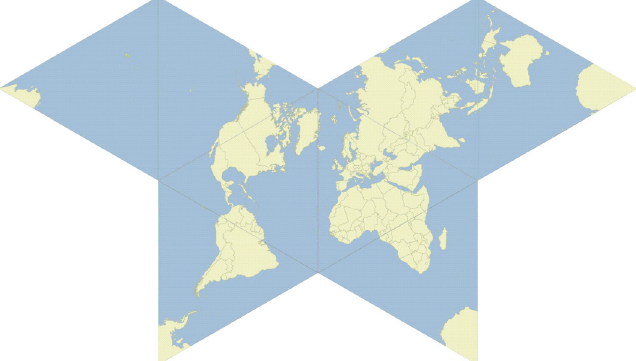
Fig. 23. Map of the World on a regular octahedron